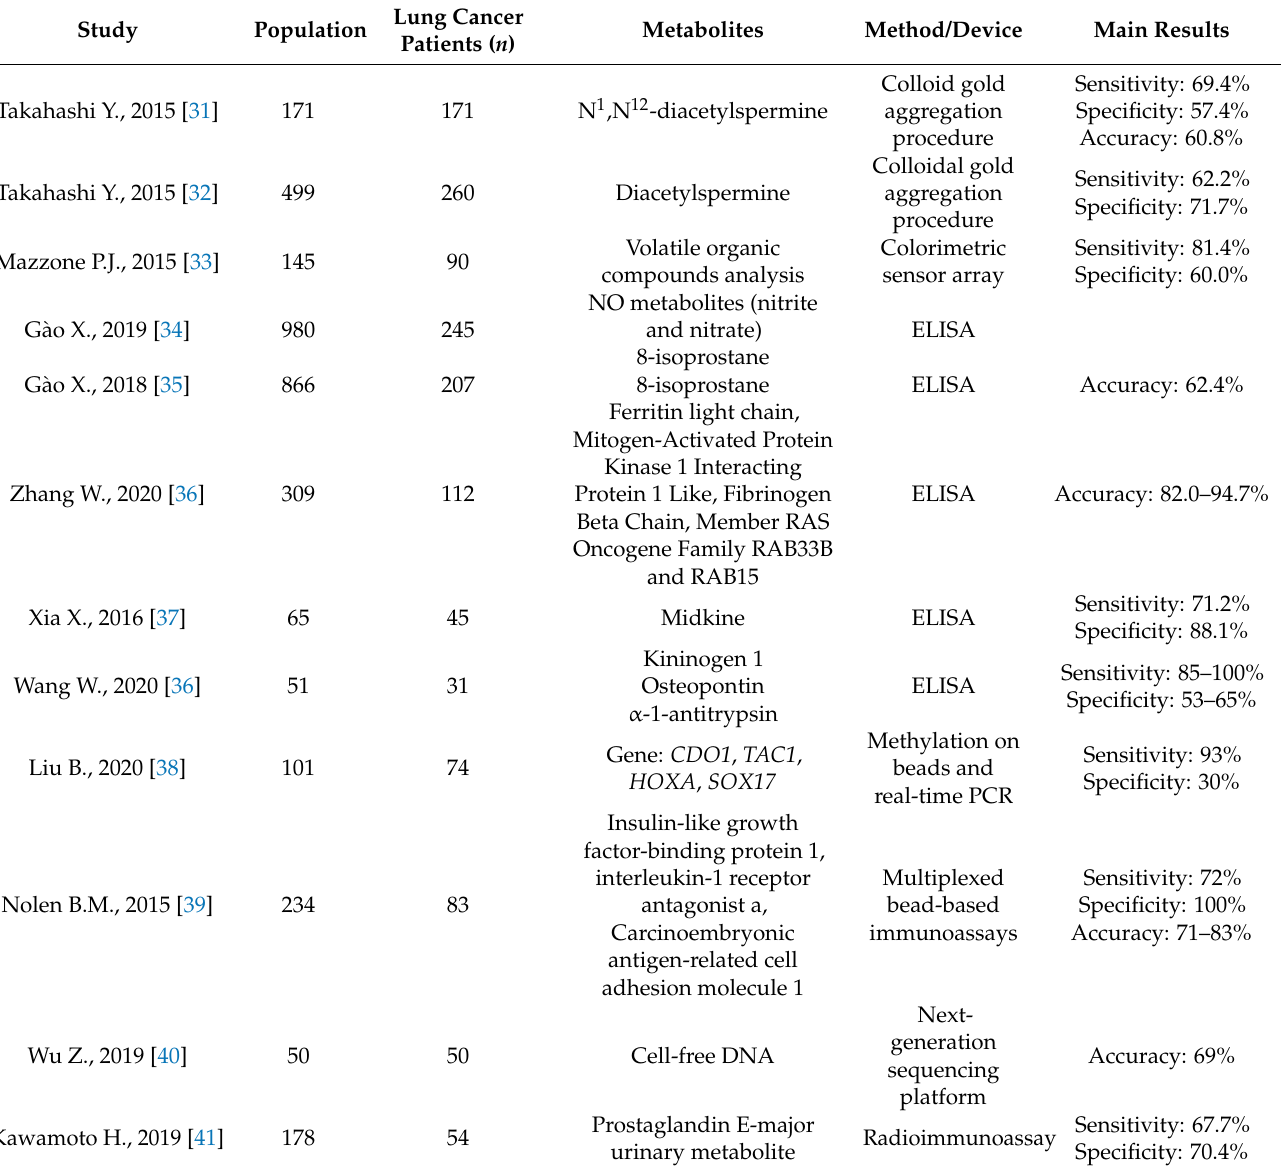
Table 3. Studies using alternative